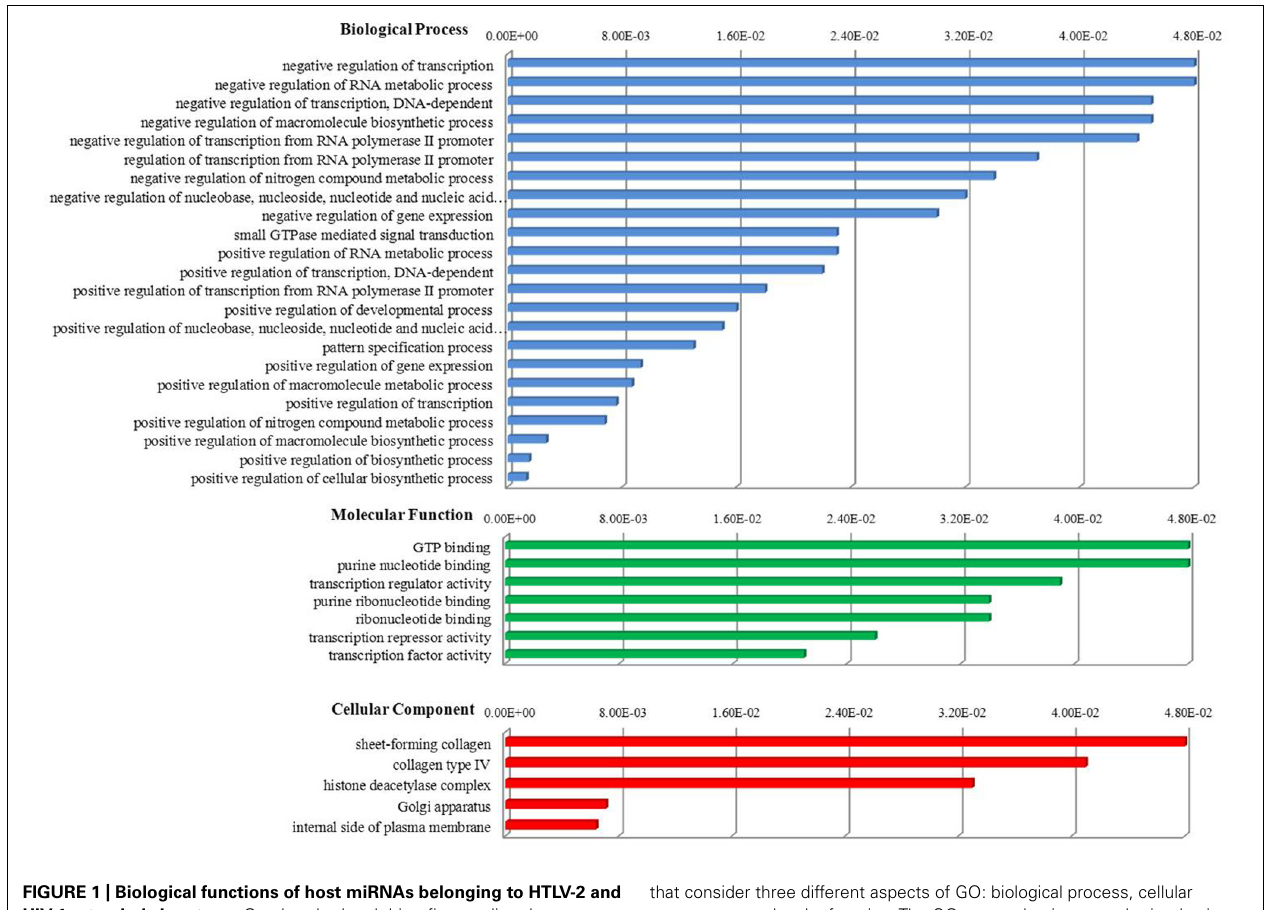
FIGURE 1 | Biological functions of host miRNAs belonging to HTLV-2 and HIV-1 retroviral signature. One hundred and thirty-five predicted target genes were identified by miRDB database (http://mirdb.org). Functional annotations were provided by DAVID bioinformatics resources (http://david.abcc.ncifcrf.gov) on the basis of gene ontology (GO) resources